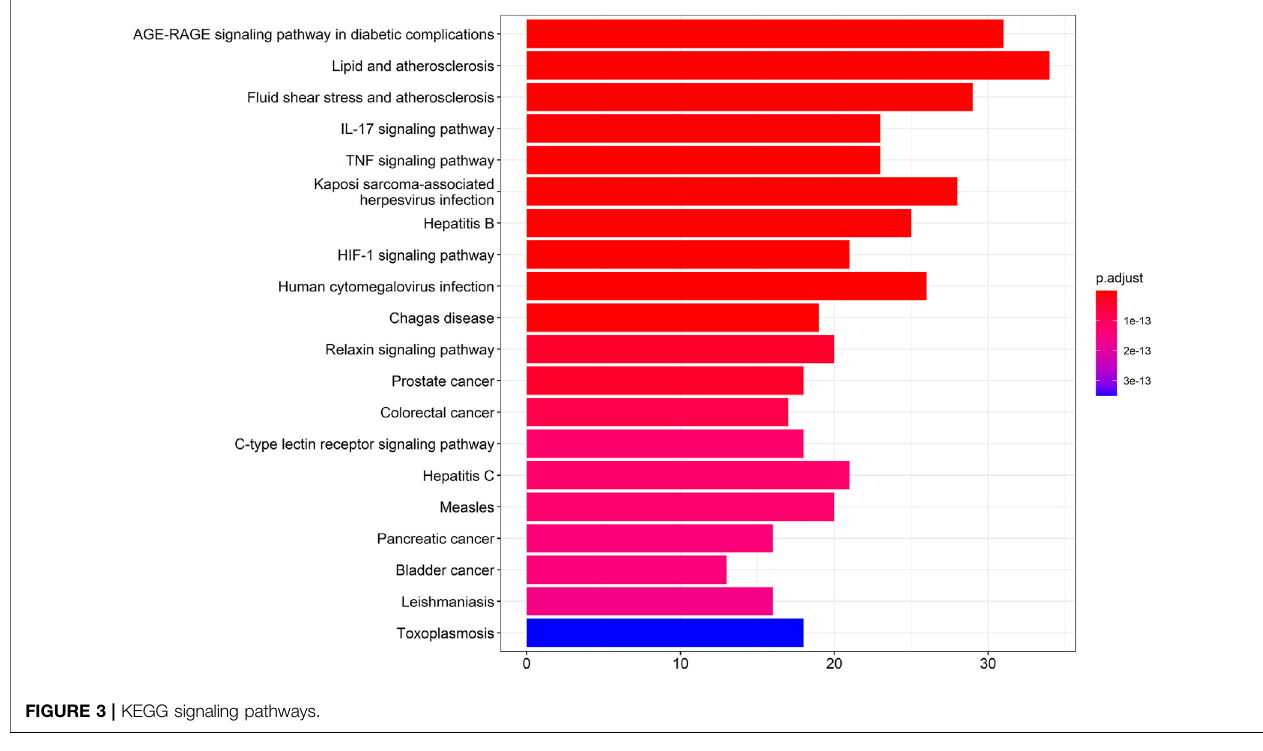
FIGURE 3 | KEGG signaling pathways.